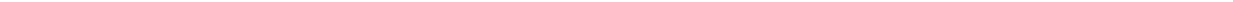
Fig. 1 Nucleation geometry controls the actin network growth rate. a , b The growth of different restricted actin organizations. a Actin network emerging from 3 × 15 µ m 2 GST-pWA-coated bar. Conditions: 6 µ M G-actin Alexa-568 labeled, 18 µ M Pro fi lin, 120 nM Arp2/3 complex, 25 nM CP. b Same as a but for GST-pWA-coated sub-micron dot. c The growth rate of actin networks was calculated in µ m s − 1 µ M − 1 of available [G-actin]. Red bars represent mean speed values. Error bars show mean s.d. for n = 20 LMs from four experiments a and n = 13 LMs from fi ve experiments b . **** p < 0.0001,